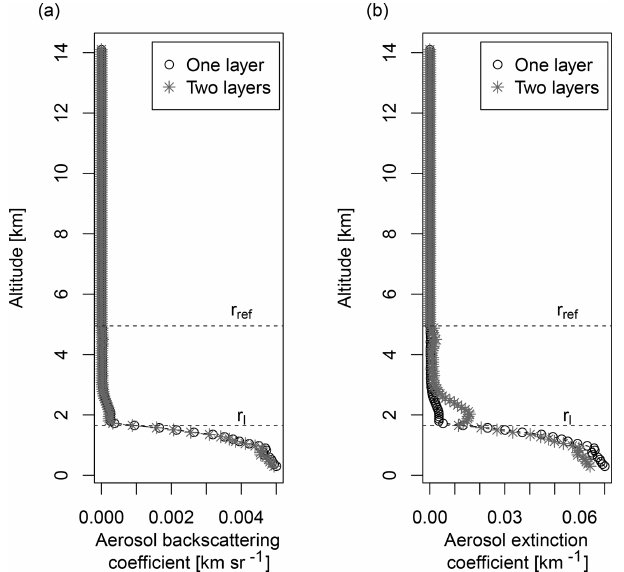
Figure 13. Example of the extinction and backscattering coeffi- cients under clean conditions obtained by using one- and two-layer methods applied to a lidar profile made on 27 December 2012 (AOD SCO = 0 . 10). Upper limits of the MBL ( r l ) and FT ( r ref ) are represented by horizontal dashed lines.